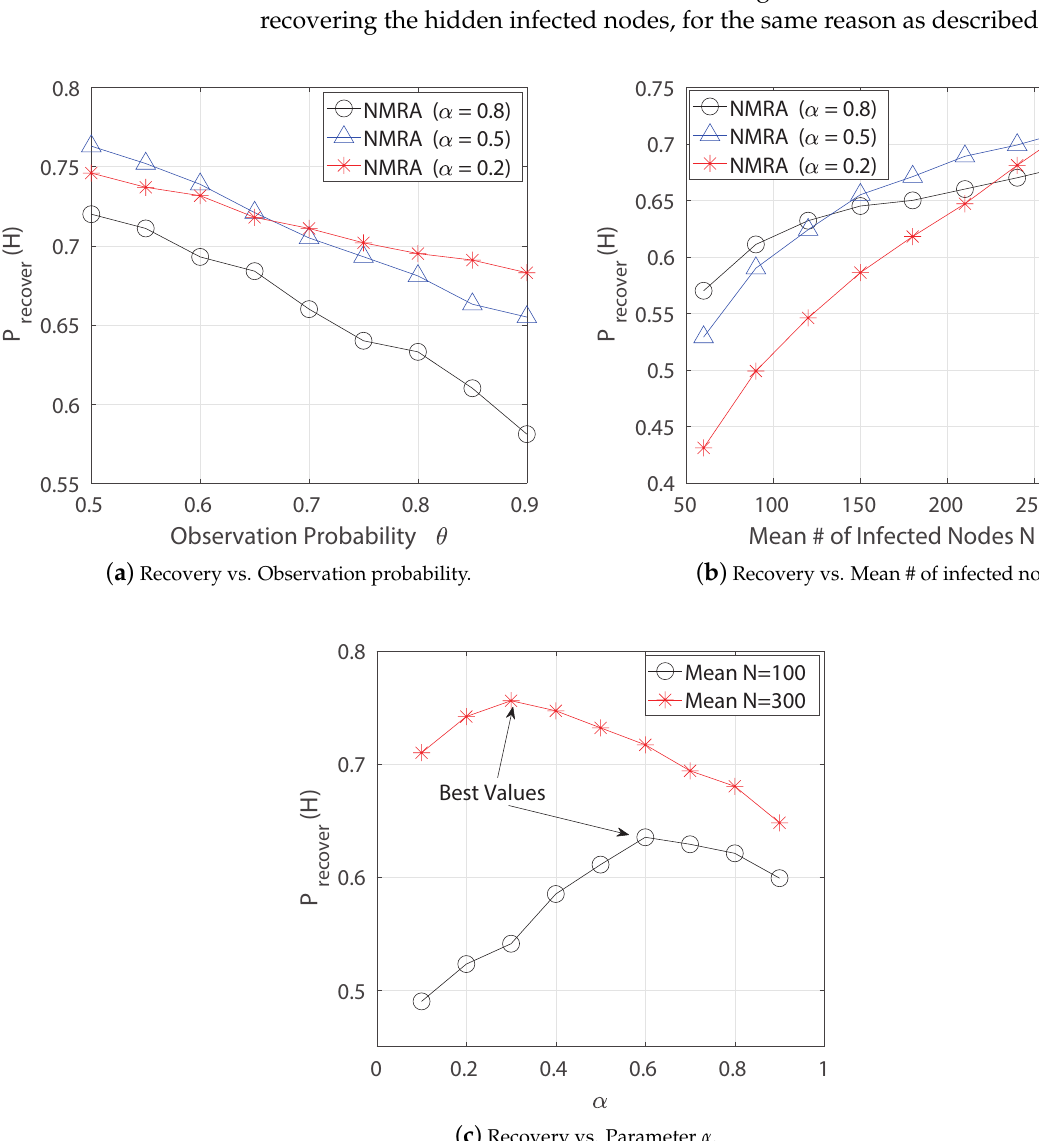
( c ) Recovery vs. Parameter α . Figure 5. Recovery probabilities of NBRA( α ) for m = 3. (( a ) Recovery as the observation probability varies from 0.5 to 0.9. ( b ) Recovery by varying the mean number of infected nodes from 60 to 300. ( c ) Recovery by varying the parameter α from 0.1 to 0.9. Here, N indicates the mean number of infected